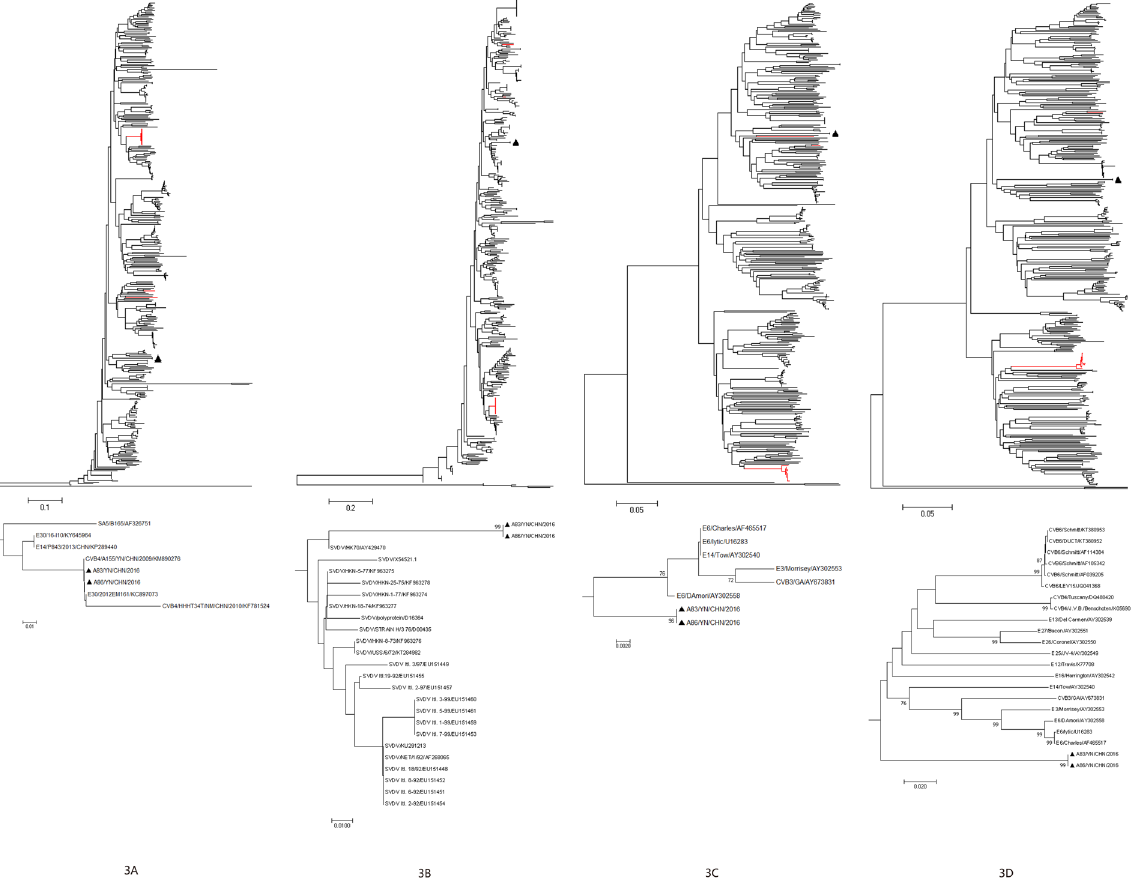
Figure 5. Phylogenetic relationships based on the 3A , 3B , 3C , and 3D coding sequences of 379 EV-B strains. Two E-18 strains and 377 EV-B strains available in GenBank database were analysed by nucleotide sequence alignment using the neighbor joining algorithms implemented in the MEGA 6.06 program. Numbers at the nodes indicate bootstrap support for that node (percentage of 1000 bootstrap replicates). The scale bars represent the genetic distance. Only high bootstrap values ( > 75%) are shown. Only high bootstrap values ( > 75%) are shown. ▲ Strains isolated in this investigation. Red denote the other E-18